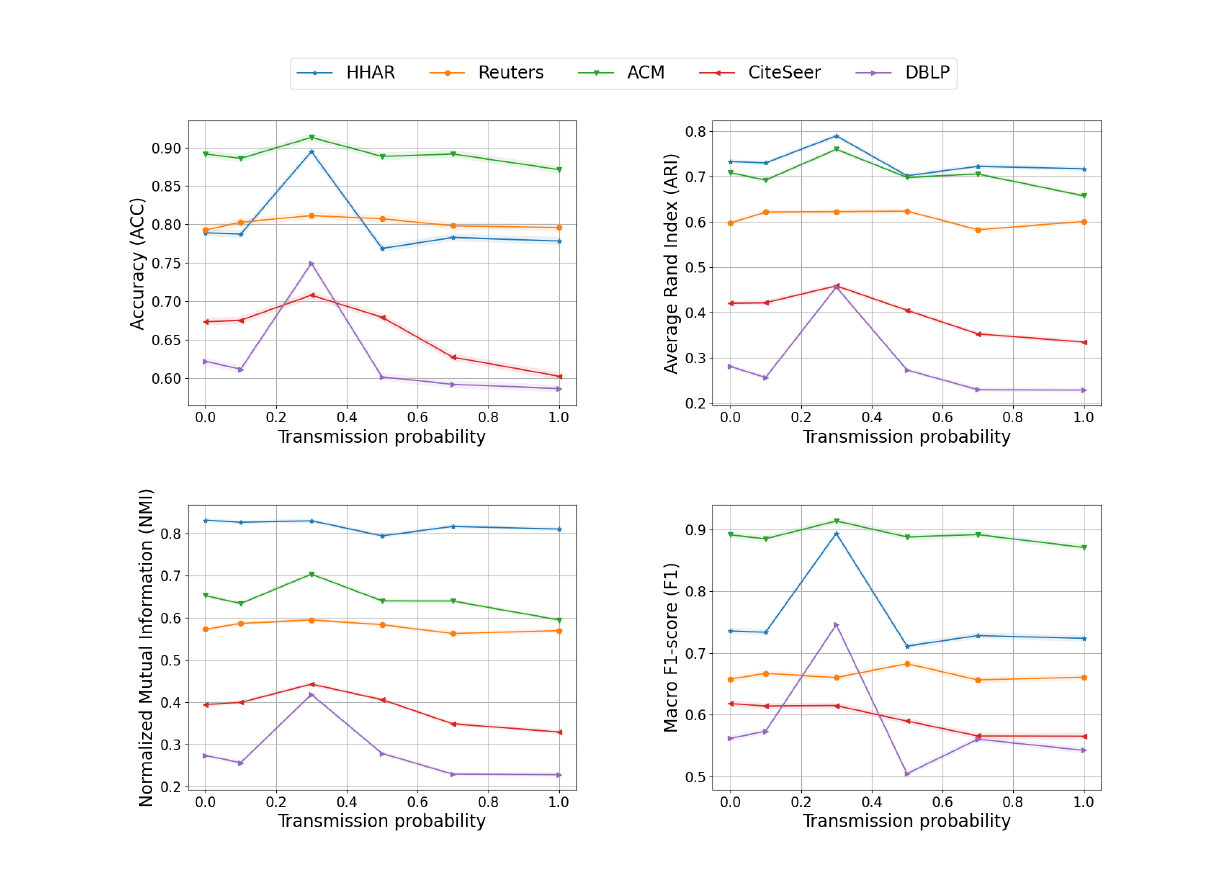
Figure 3. Analysis of transmission probability α . Through these four pictures, we can notice that when α = 0.3, our model have the best performance for different